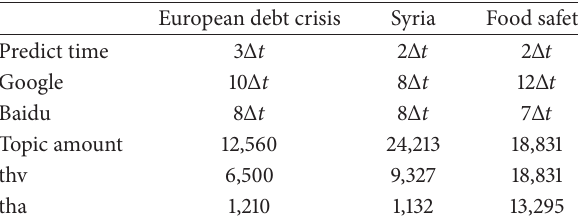
Table 3: Topic recognition time with topic